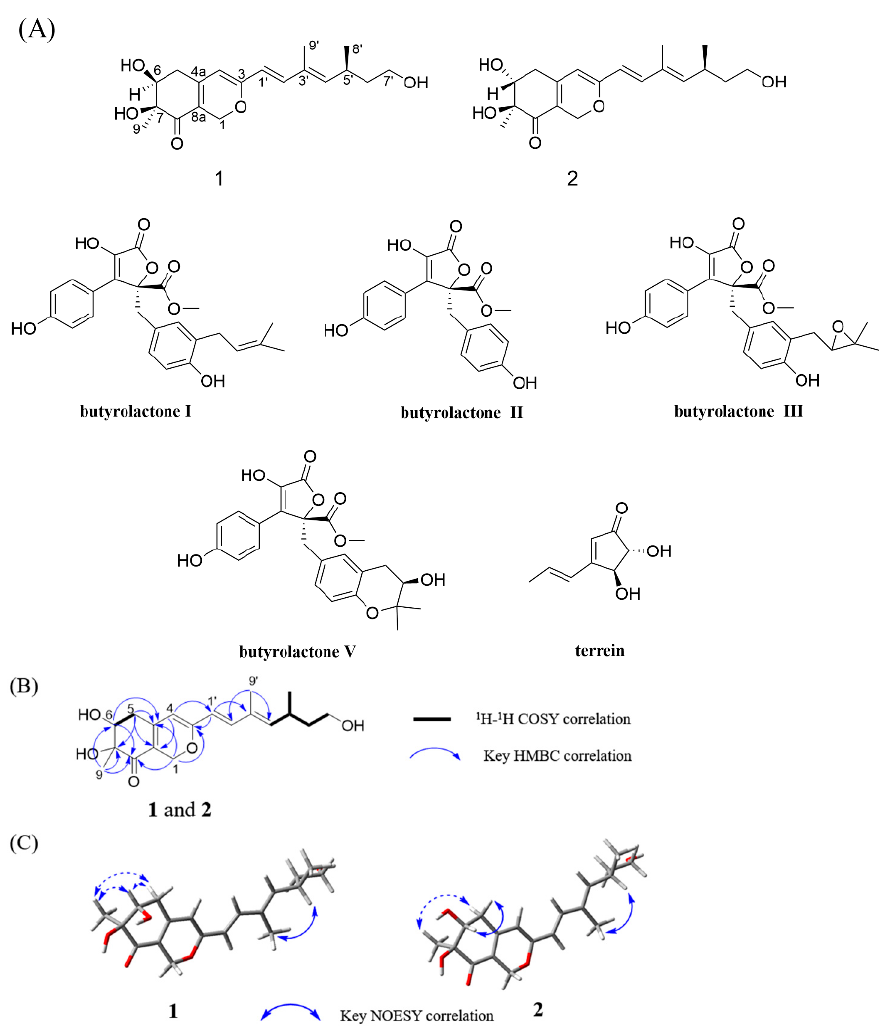
Figure 5. ( A ) The structures of compounds 1 and 2 and known compounds. ( B ) Key 1 H- 1 H COSY and HMBC correlations of 1 and 2 . ( C ) Key NOESY correlations of 1 and 2